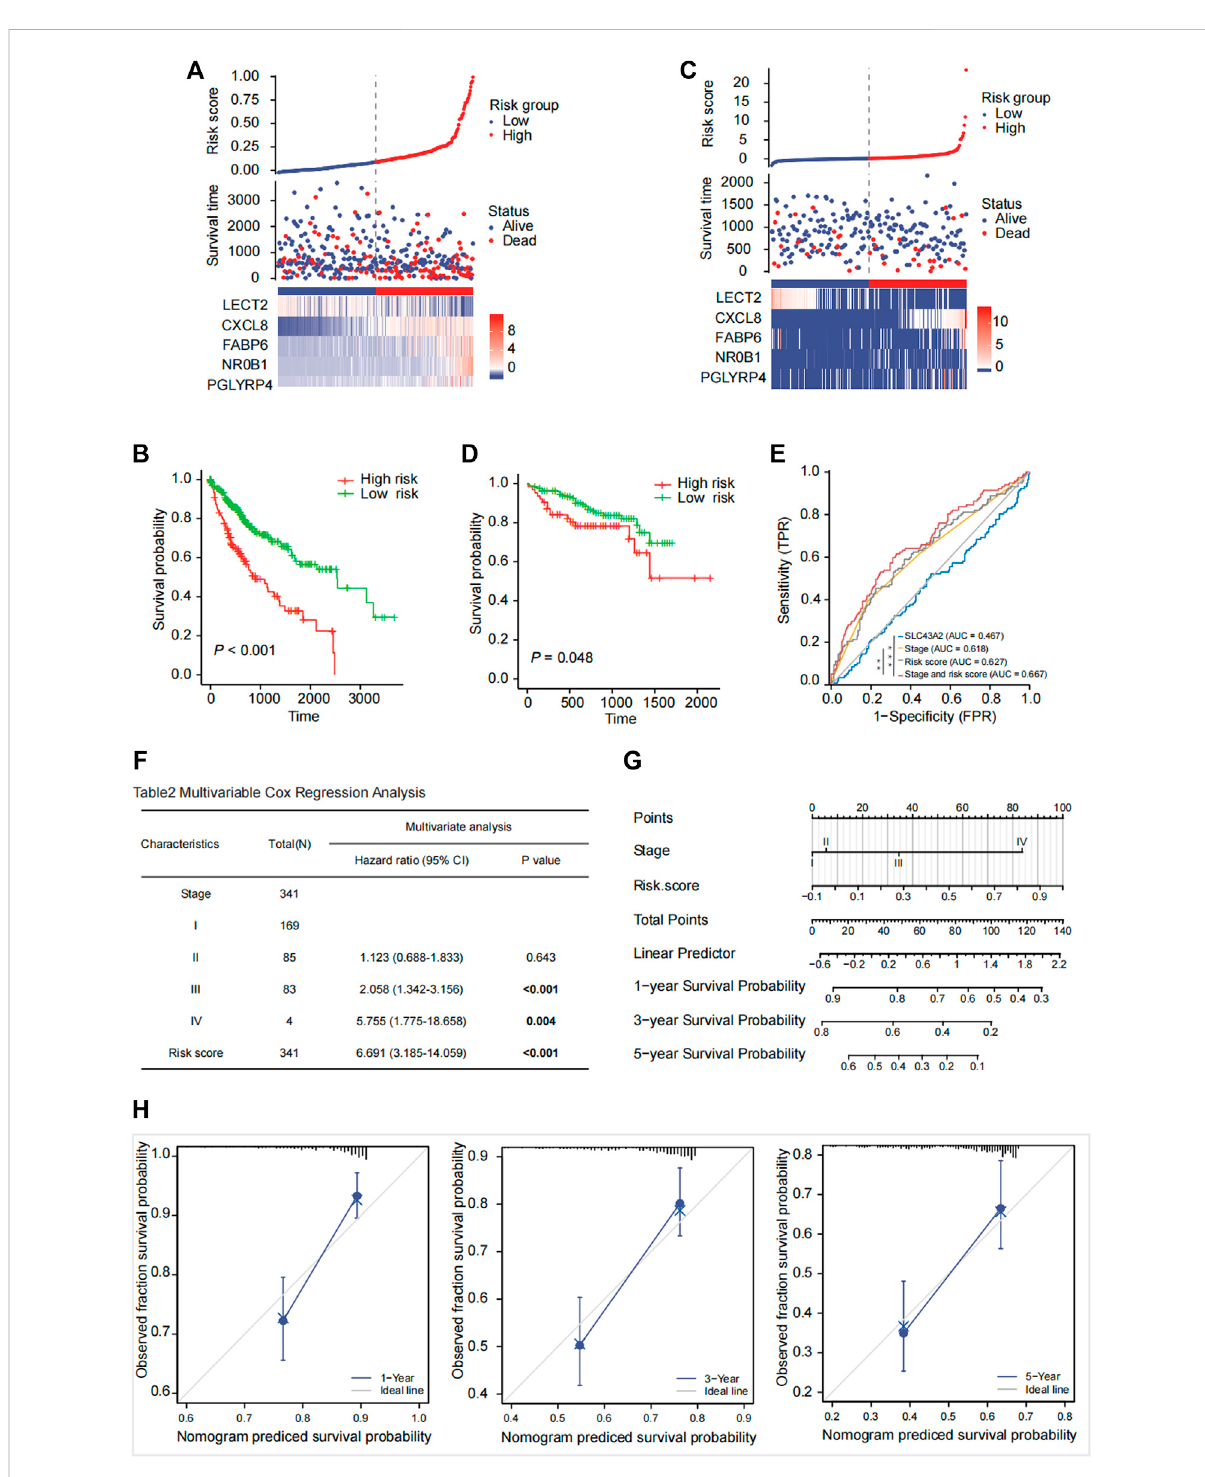
FIGURE 7 Risk score model prediction and validation. Building a fi ve-gene signature risk score in the TCGA-LIHC cohort (A) with the OS probability for high and low risk patients (B) and validating in the ICGC-LIRI-JP cohort (C, D) . The risk score was calculated based on the expression of 5 genes ( LECT2 , CXCL8 , FABP6 , NR0B1 , PGLYRP4 ). The Kaplan-Meier survival curves of OS between high-risk and low-risk groups were shown in TCGA- LIHC cohort[ (B) , p < 0.001] andintheICGC-LIRI-JP cohort[ (D) , p =0.048].ROC analysis tocompareSLC43A2, stage, riskscore,stageand risk score in predicting survival [ (E) , AUC = 0.467, 0.618, 0.627, 0.667]. Multivariate Cox regression analysis of OS based on stage and risk score in the TCGA cohort (F) . A nomogram was constructed based on stage and risk score (G) . Calibration plot evaluating the predictive accuracy of the nomogram at 1-, 3-, and 5-year survival (H)